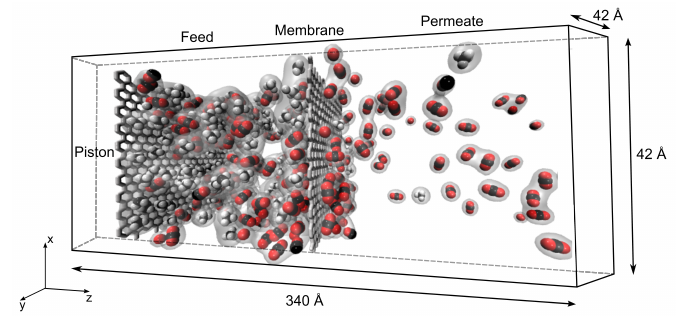
Figure 1. Example of a structure modeling the gas separation process. The graphene membrane is placed in the middle of the cell while the graphene piston is on the left. Carbon atoms are represented in gray/black, oxygens in red and hydrogens in white. The shaded areas represent the Van der Waals surfaces of gas